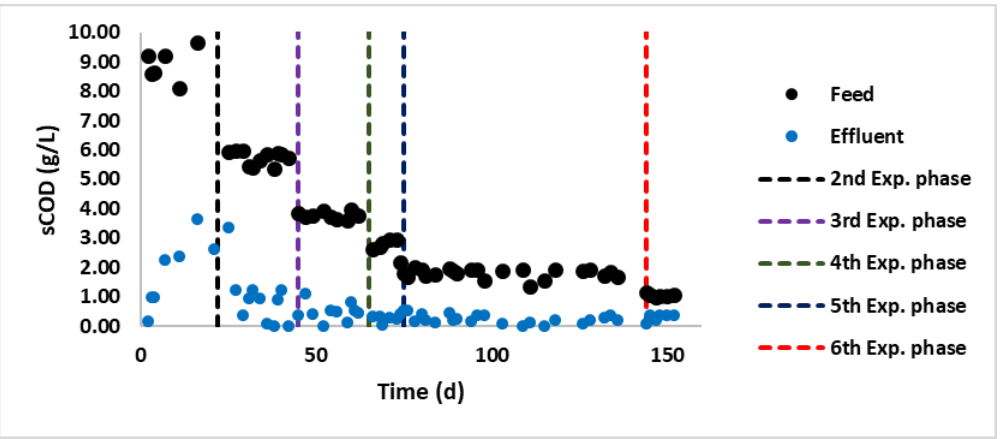
Figure 4 . Daily sCOD of the reactor’s feedstock and effluent.